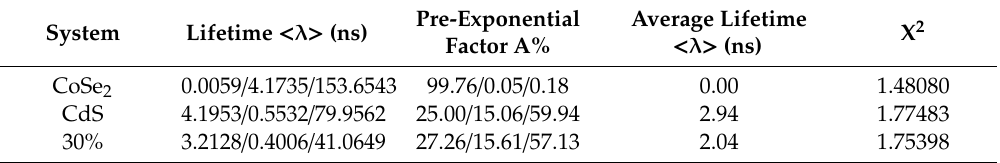
Table 2. Decay parameters of pure CdS, CoSe 2 , and CoSe 2 / CdS ranging from 10% to 50%. System